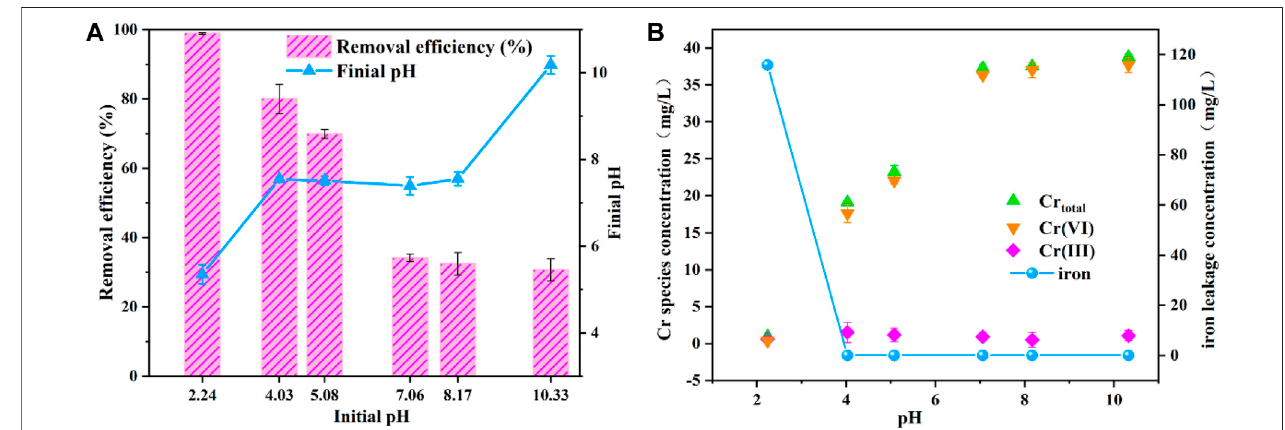
FIGURE 4 | Effects of solution initial pH on the Cr(VI) removal effect in water (A,B) .